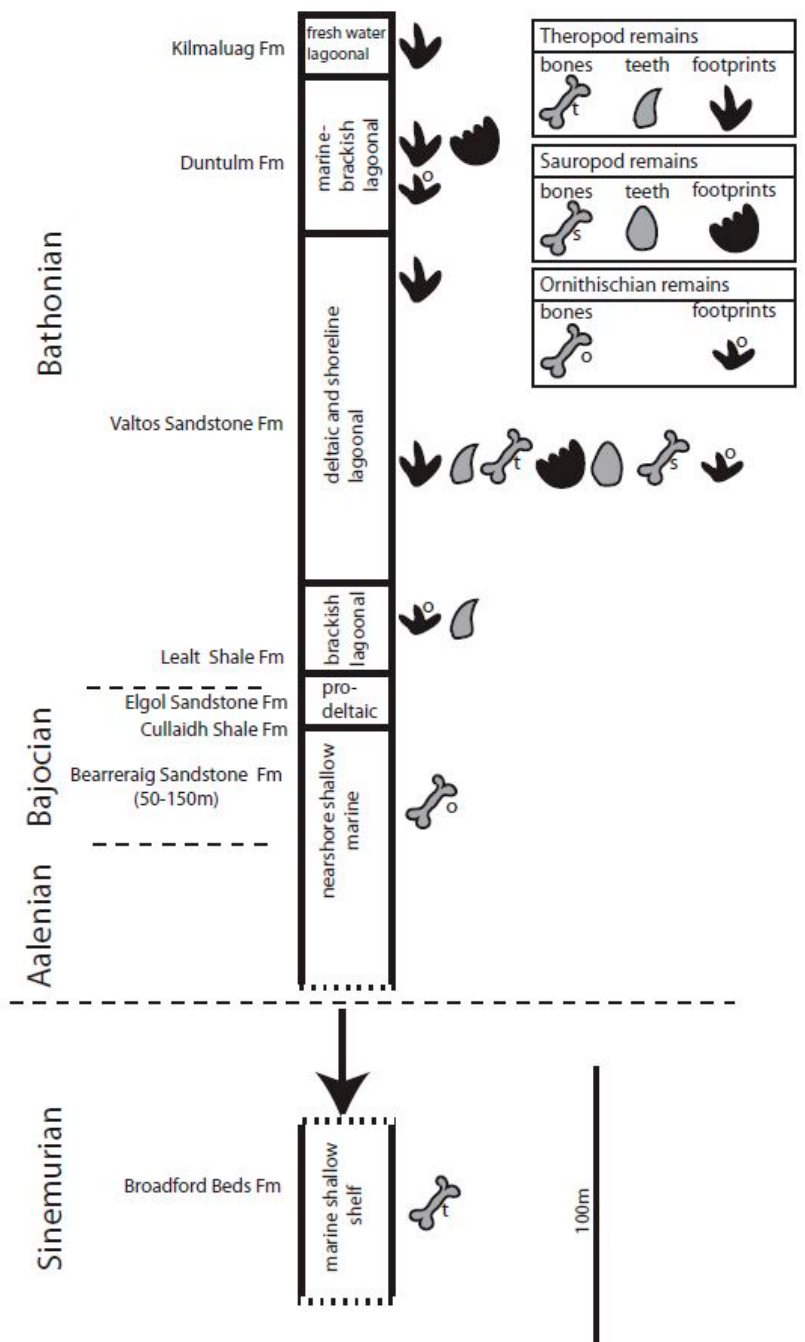
Figure 2. Succession of Jurassic dinosaur-bearing formations on the Isle of Skye and their approximate age as well as types of dinosaur remains contained within each formation.